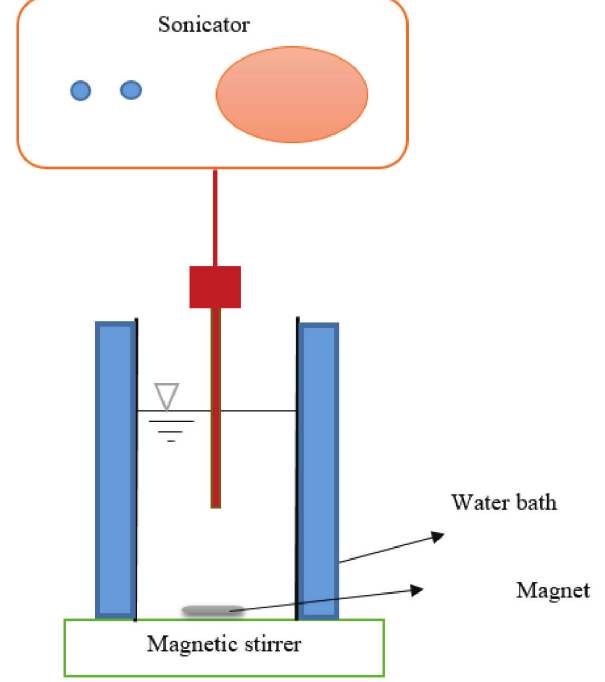
Fig. 1 – Reactor of CWPO/US-Fe